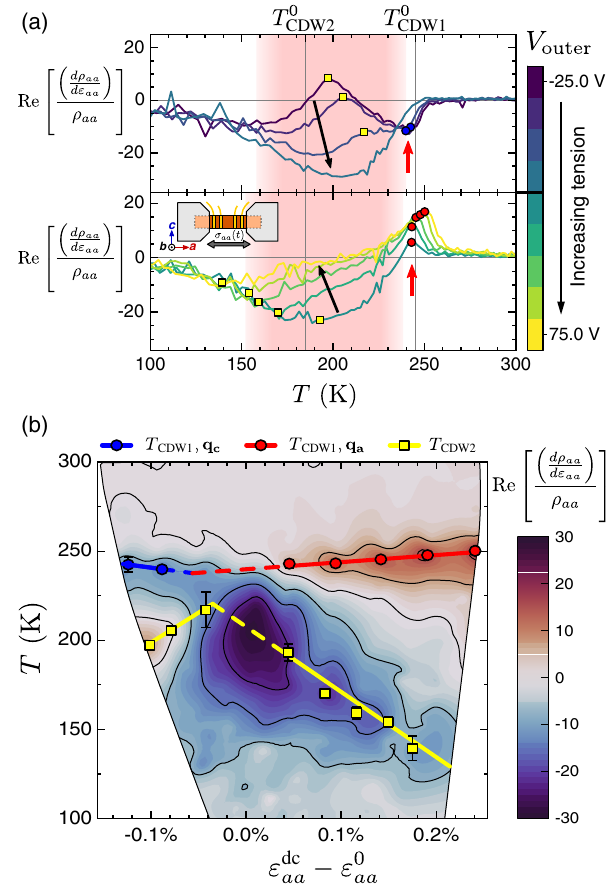
FIG. 9. Longitudinal a -axis elastoresistivity in TmTe 3 . Data presented here were taken by stepping the PZT voltage while sweeping temperature and extracted for steps of increasing tension only. (a) Elastoresistivity as a function of temperature and PZT voltage. Traces are all from the same sample, but have been separated into two panels for clarity. The top panel contains the responses for the most compressive, least tensile stress conditions, and the bottom for the largest tensile stresses. Short red arrows point out the peaks and dips attributed to T , and CDW 1 the shaded regions highlight the “ bulge ” feature. (b) The same data as in (a) presented in the strain-temperature plane. Symbols correspond to the extracted extrema in the traces in (a). Solid lines are linear fits to the extracted transition positions and dotted lines denote an extrapolation to the intersection points. In conjunction with the evidence for a first-order transition as shown in Fig. 7, this diagram maps most closely onto the phase diagram presented in Fig.